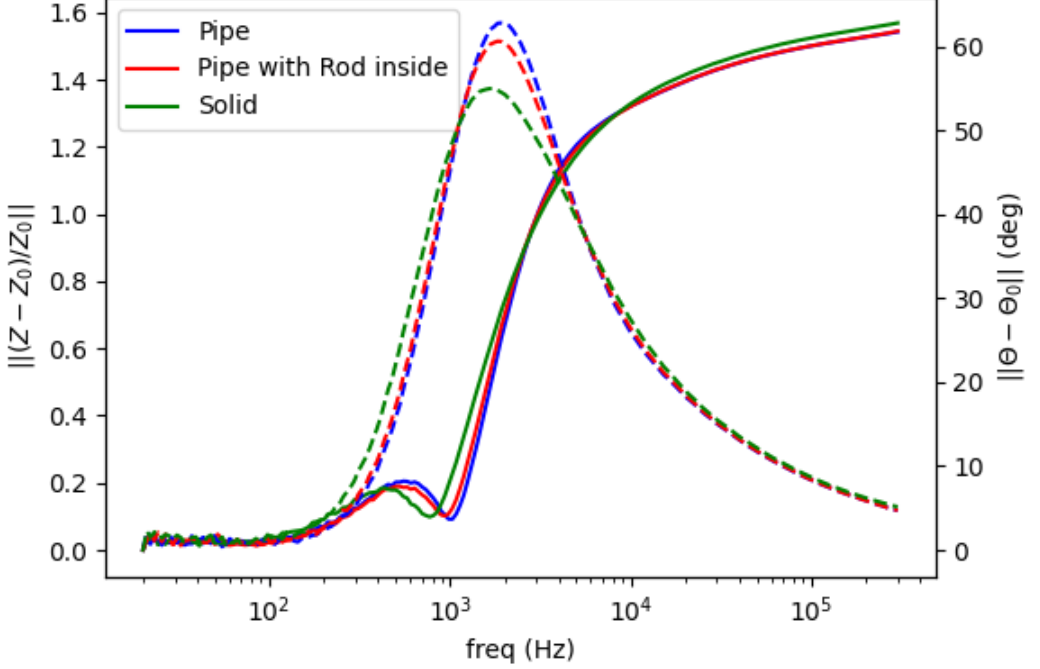
Figure 6. Spectral plot for metallic structure. Solid line for amplitude ratio (left vertical axis); dashed line for phase difference (right vertical axis).